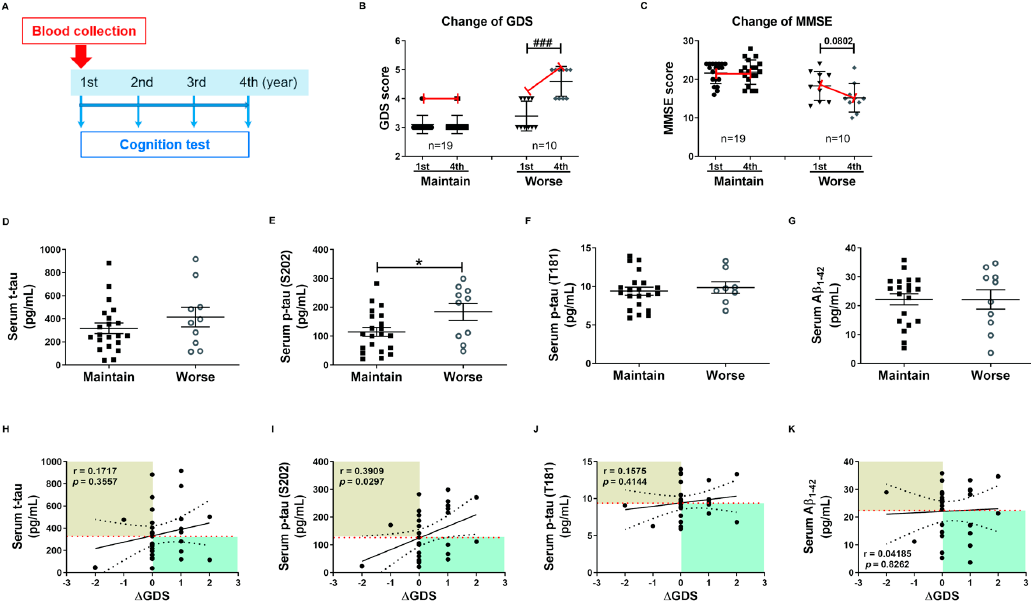
Figure 3. High baseline p-tau in serum predicts long-term cognitive deterioration. ( A ) Timeline of the